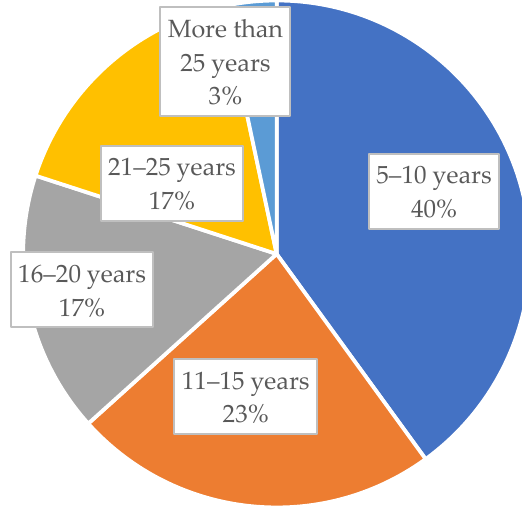
Figure 2. Experience of the participants in the survey.